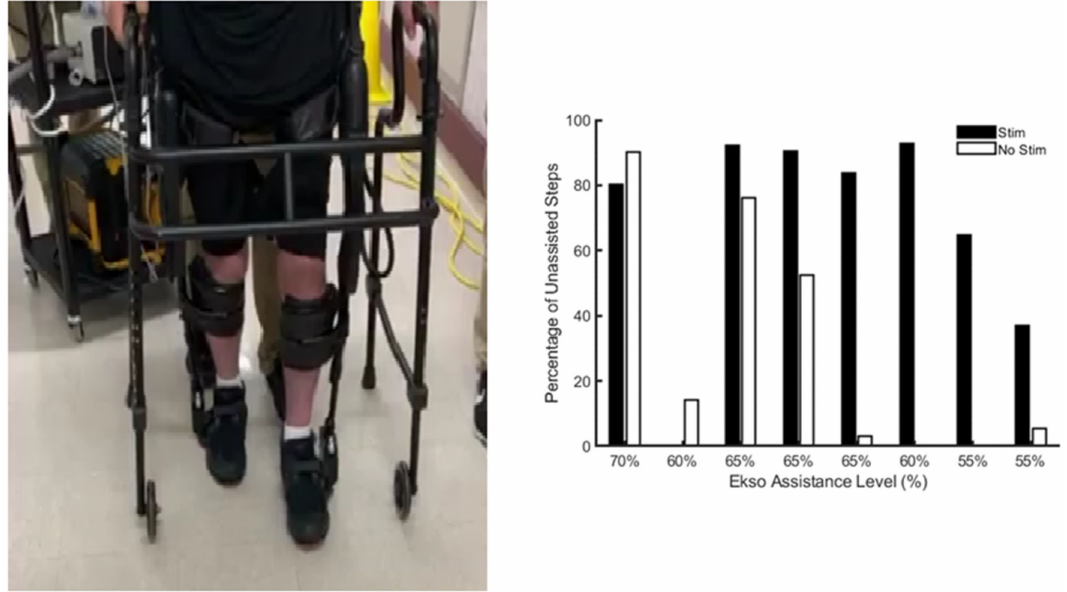
Figure 2. The use of exoskeleton assisted walking with TSS to facilitate stepping at lower level of assistance in a person C6 motor complete SCI. Percentage of unassisted steps during 10 m walking test was determined by the number of steps that the person could imitate on their own without triggering the audible sound of the exoskeleton compared to the total number of steps. Triggering the audible sounds indicated that the robotic exoskeleton initiated the steps. It is typical to have around 16–18 total steps per leg with a swing complete time set at 0.5 s. Only with the TSS, the person with SCI could provide active assisted stepping at a lower level of assistance that was provided by the